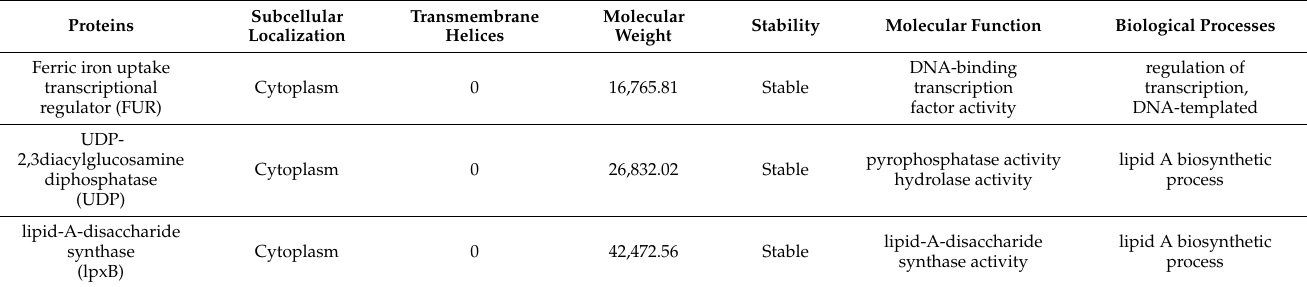
Table 1. Details of selected drug targets.